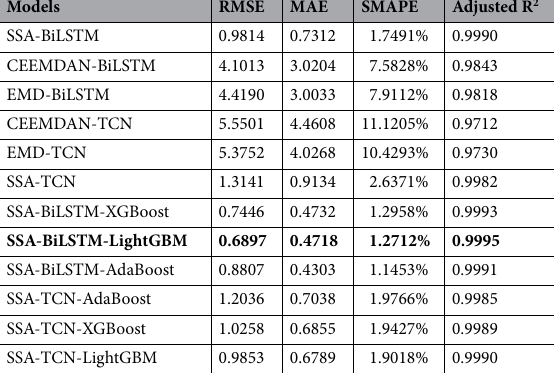
Table 2. Prediction results of the combined model. The significant values are in bold.